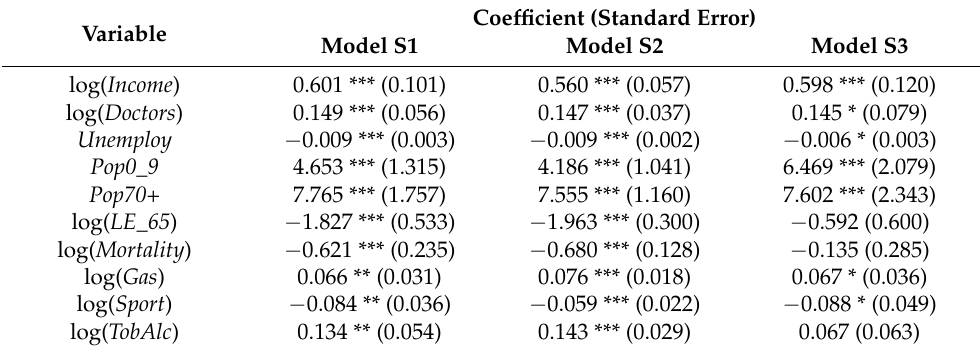
Table 4. Estimates of panel-data regression models illustrating determinants of real out-of-pocket health expenditure in Polish regions in years 1999–2019 using alternative